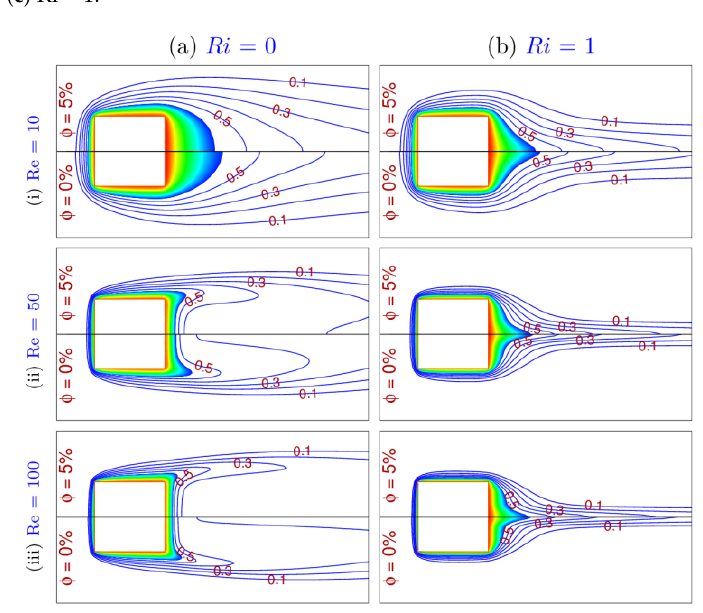
Figure 10. Time-averaged isotherms for different values of Re and Ri at ϕ = 5%: ( a ) Ri = 0, ( b ) Ri = 0.5, ( c ) Ri = 1.